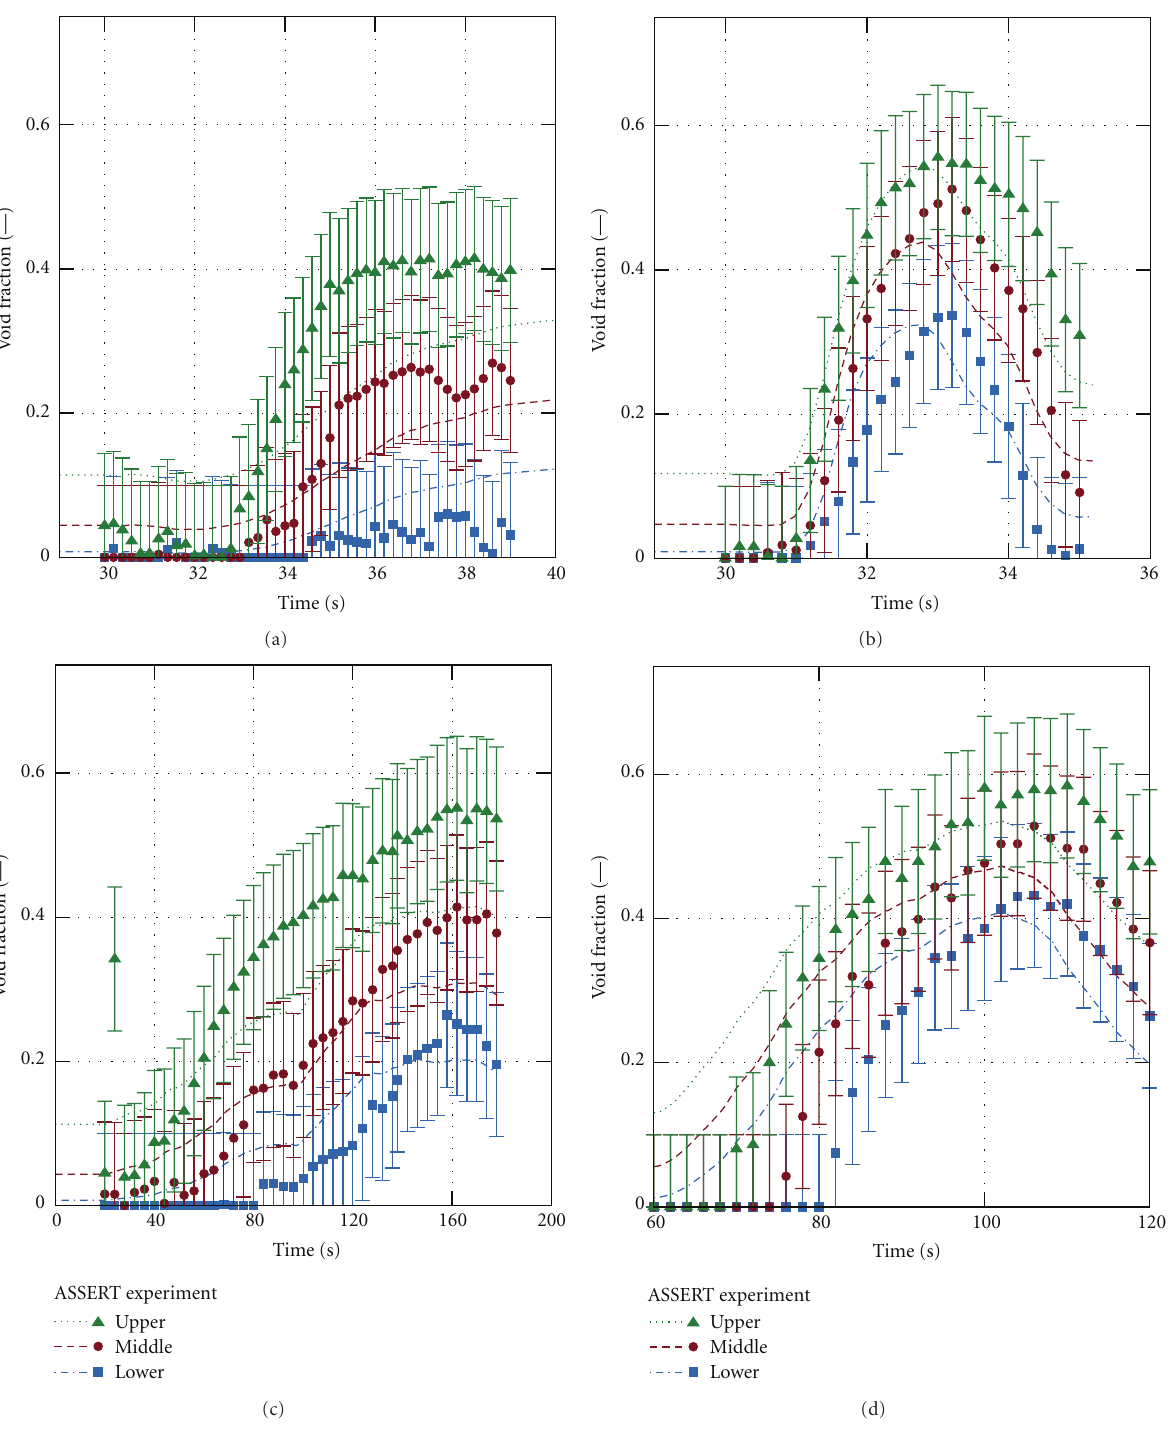
Figure 13: Transient void fraction results for bundle test series B5. Power increase (a), flow reduction (b), depressurization (c), and inlet temperature increase (d). Error bands displayed correspond to 2 σ exp = 0 .